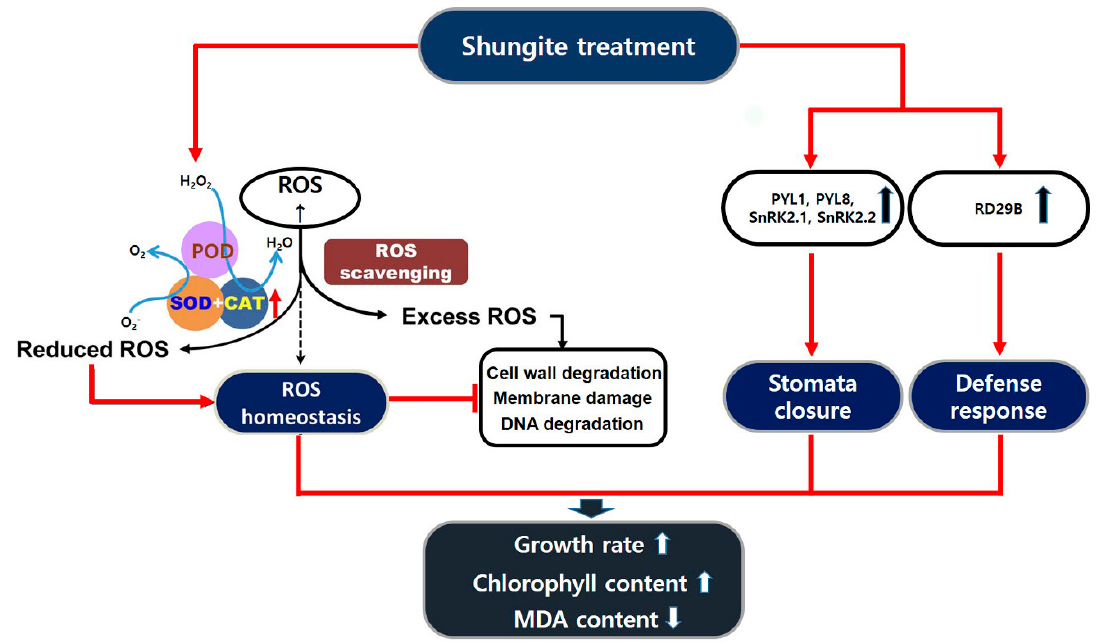
Figure 7. Schematic diagram of shungite induced tolerance in cucumber under drought stress. Red solid arrows indicate plant affected by shungite directly. Drought stress induces ROS production and various damages, including cell wall degradation, membrane damage, and DNA and protein degradation. The application of shungite to soil increases the activity of ROS scavengers and reduces cellular damage. This leads to better growth rate and higher chlorophyll content. It also triggers the expression of genes for stomata closure and defense reaction.